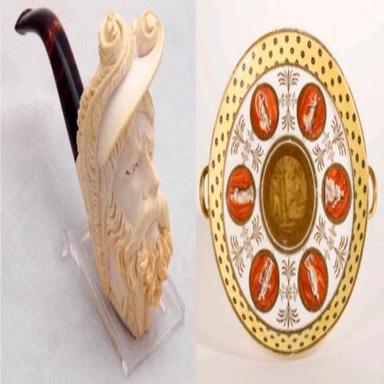
Ancient artistic objects made in sepiolite. On the left: "Vintage Carved Meerschaum Estate Tobacco Pipe "(Reproduced from (, photo by Joe Haupt, CC BY-SA 2.0). On the right: Porcelain tray manufactured with sepiolite at the Royal Porcelain Factory of Buen Retiro ((Cerralbo Museum, Madrid, Spain. Access number 1678, photo by Angel ´ Martínez Levas).